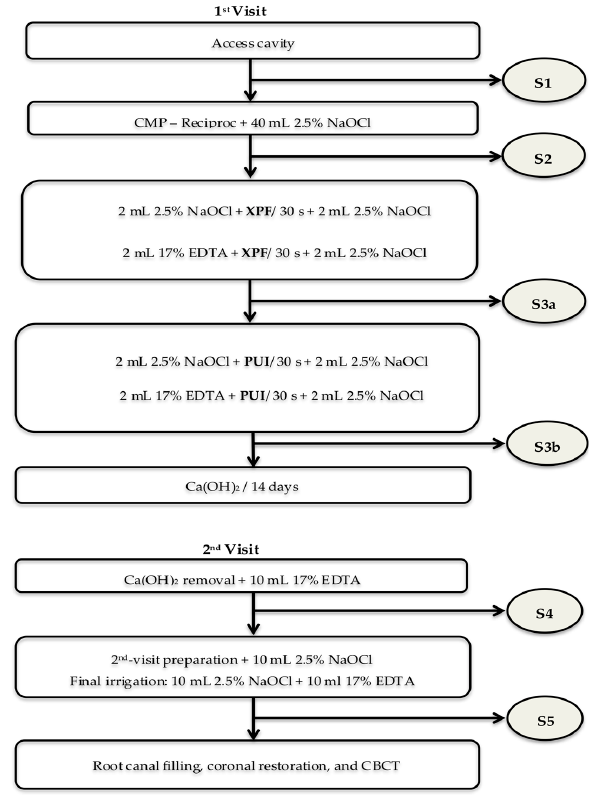
Figure 1. Flow chart of the interventions. The root canal samples were taken after access cavity (S1), root canal preparation (S2), XP-endo Finisher (XPF) (S3a), PUI (S3b), calcium hydroxide medication (S4) and 2nd-visit root canal preparation